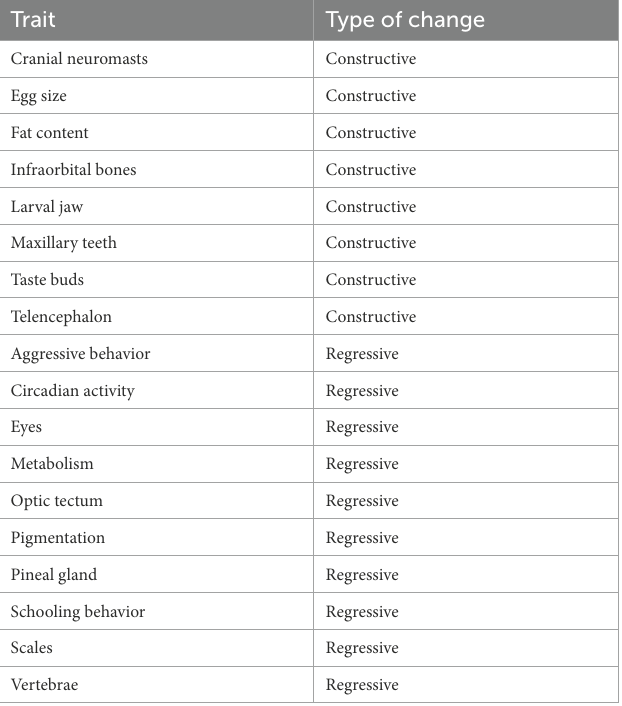
TABLE 1 Constructive and regressive changes in Astyanax cavefish, modified and simplified from Jeffery (2001). Trait Type of